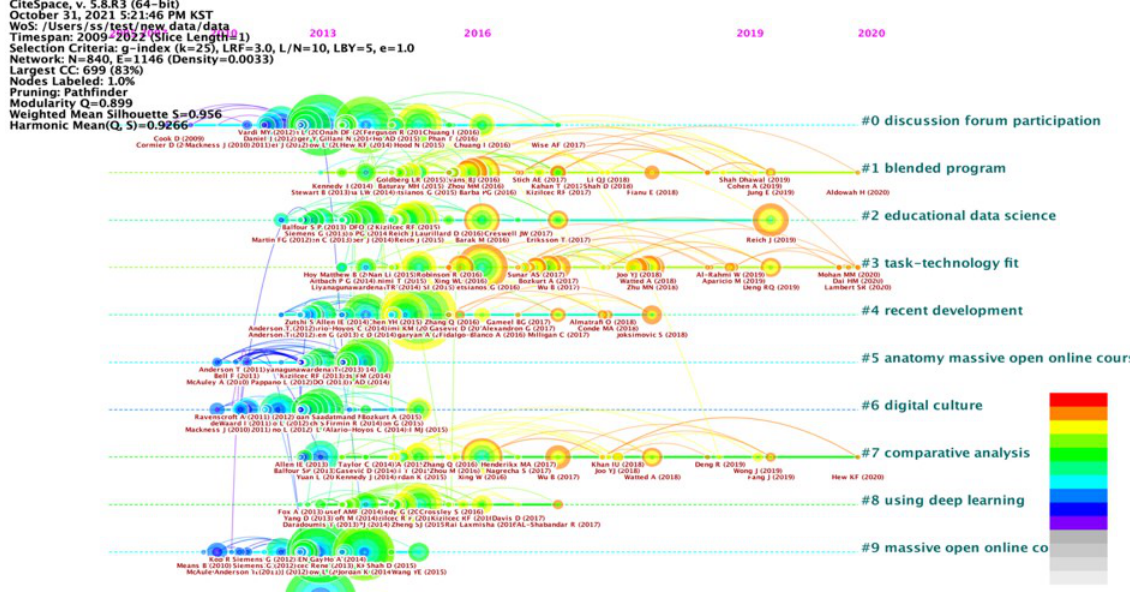
Timeline Map of the Top Nine Research